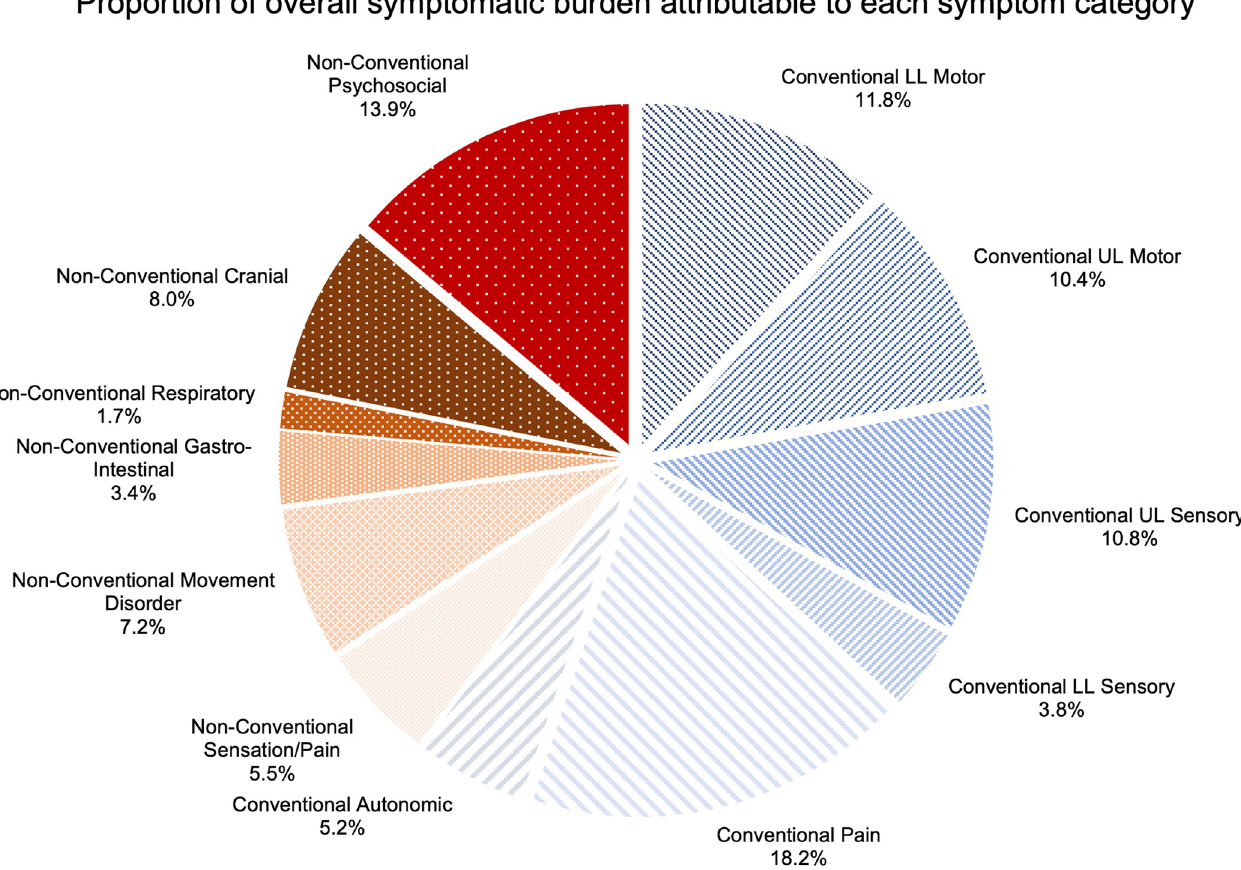
Fig 3. Pie chart illustrating the proportion of overall symptoms reported that were attributable to each symptom category. Conventional symptom segments are illustrated with lines and non-conventional symptom segments with dots.